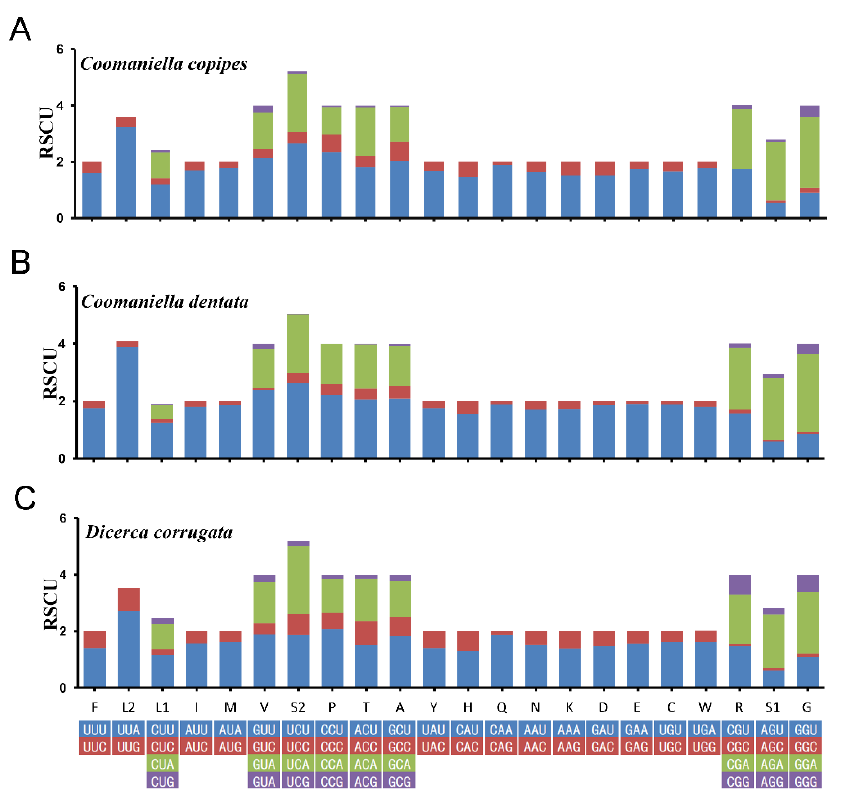
Figure 3. Relative synonymous codon usage (RSCU) of the mitogenomes of the three Buprestidae species; the stop codon is not included. Coomaniella copipes ( A ), Coomaniella dentata ( B ), Dicerca corrugata ( C ).